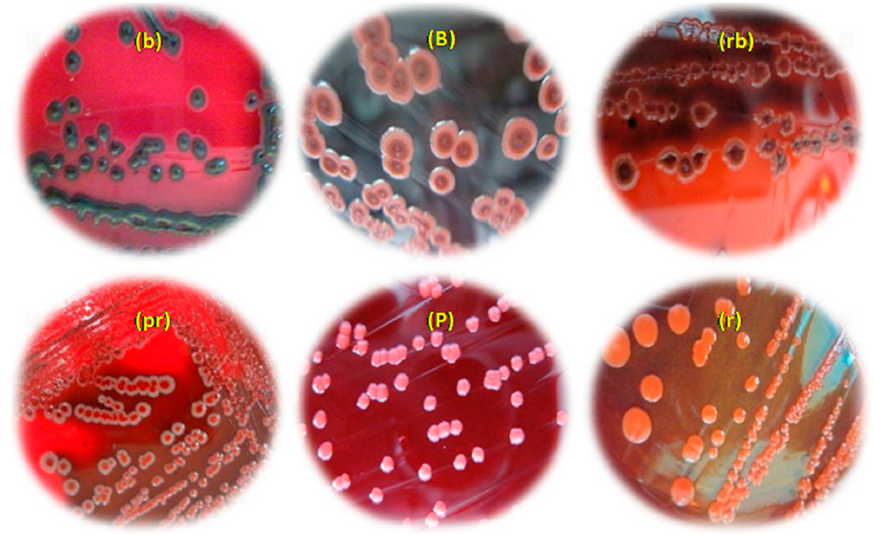
Figure 1. Morphotypes obtained on Congo red agar based on the colorimetric scale: ( b ): black colonies; ( B ): bordeaux colonies; ( rb ): red colonies with a darkening at the center; ( pr ): pink colonies with a red centre; ( P ): pink colonies; ( r ): red colonies.